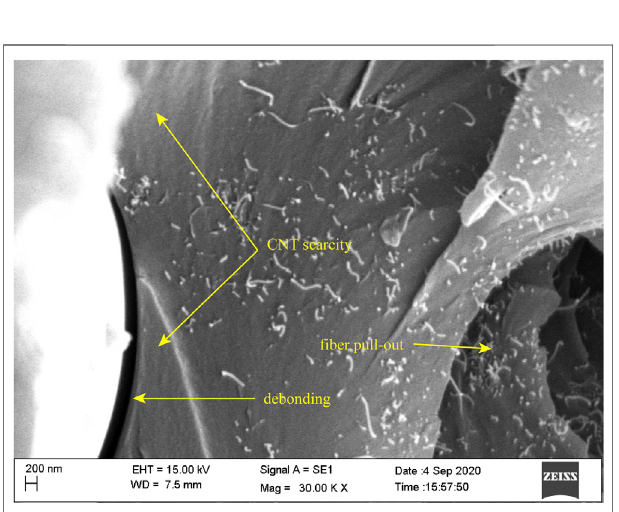
FIGURE 9 | CNT dispersion in EGC